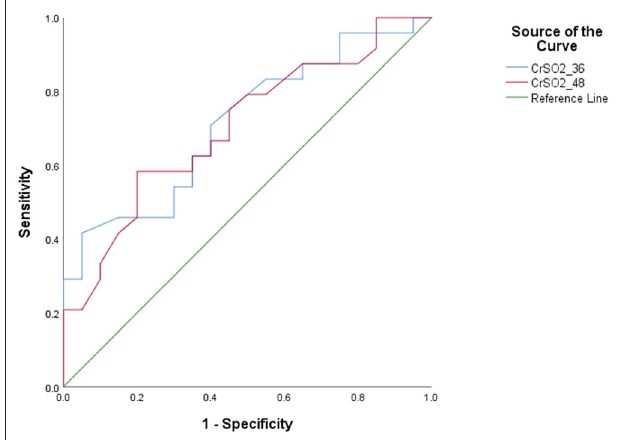
FIGURE 2 | Receiver operating characteristic curves (ROC) of CrSO2 (36h) and CrSO2 (48h) between survivors and non-survivors.